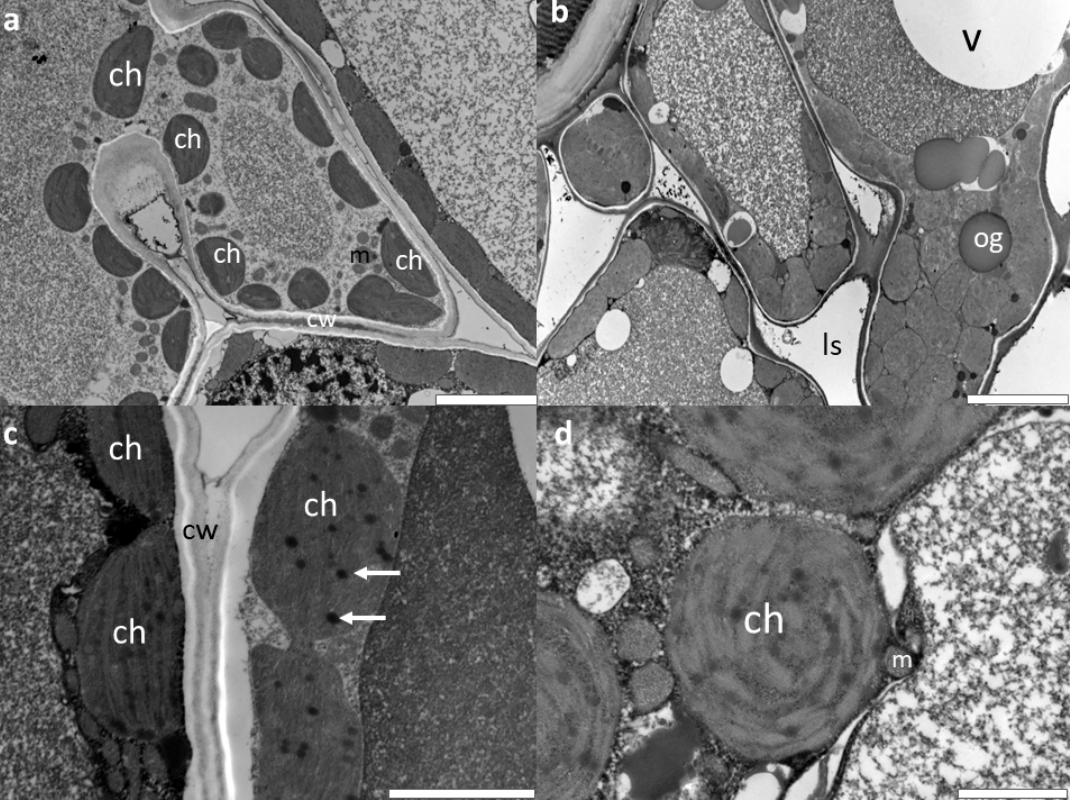
Figure 1. Ultrastructure of pine needles under TEM. ( a ) Cross-section of mesophyll cells in control needle. ( b ) Plant treated with 50 ppm AgNPs—osmophilic globules in cytoplasm. ( c ) Plant treated with 50 ppm CuNP—chloroplast with disturbed ultrastructure and many plastoglobules. ( d ) Chloroplasts in seedlings treated with 50 ppm AgNPs are of shape modified from lenticular to round. Abbreviations: cw—cell wall; m—mitochondrion; ch—chloroplast; is—intercellular space, v—vacuole; og—osmophilic globule; white arrow—plastoglobule. Scale bars: a = 5 µ m, b = 10 µ m, c = 2 µ m, d = 1 µ